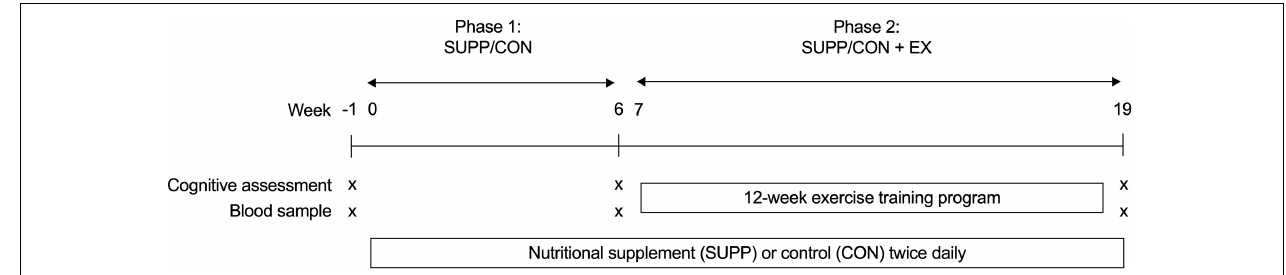
FIGURE 2 | Experimental design. Participants consumed either an experimental supplement (SUPP) or control (CON) beverage twice per day for 20 weeks (weeks 0–19, inclusive). Between weeks 7–18 (inclusive), participants completed a 12-week exercise training program. Exercise training consisted of RET twice weekly (Mondays and Fridays) and HIIT once per week (Wednesdays). At weeks –1 (baseline), 6, and 19 we assessed cognitive function and obtained a blood sample for the measurement of BDNF, 25(OH)D, and erythrocyte plasma membrane phospholipid composition. Phase 1: SUPP/CON took place between weeks 0–6, and Phase 2: SUPP/CON + EX took place between weeks 7–19. SUPP, supplement; CON, control; RET, resistance exercise training; HIIT, high-intensity interval training; BDNF, brain-derived neurotrophic factor; 25(OH)D, 25-hydroxyvitamin